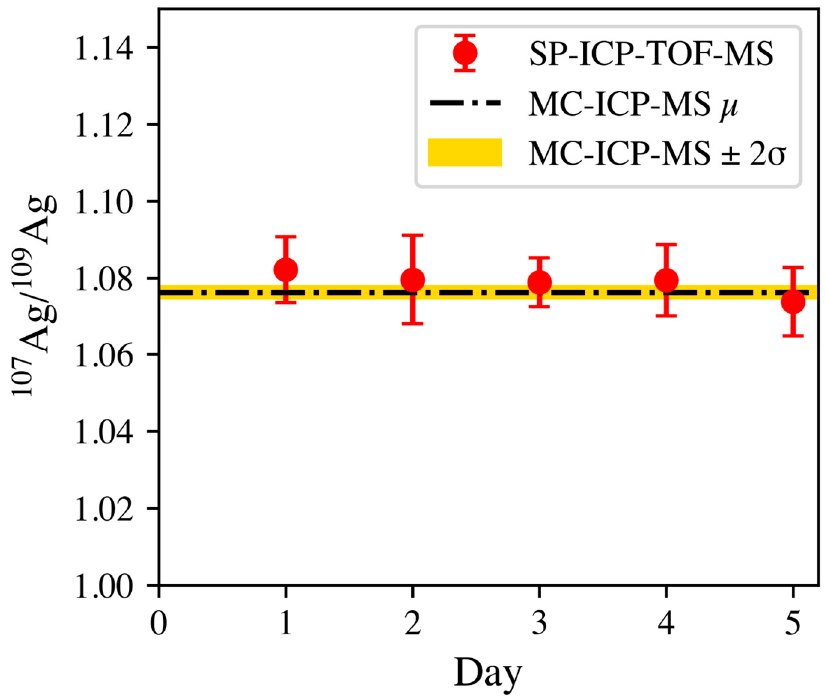
Figure 6. Depiction of the 107 Ag/ 109 Ag isotope ratio, determined by SP-ICP-TOF-MS, over the course of 5 days with respect to the determined value via bulk digestion-MC-ICP-MS (dashed line).